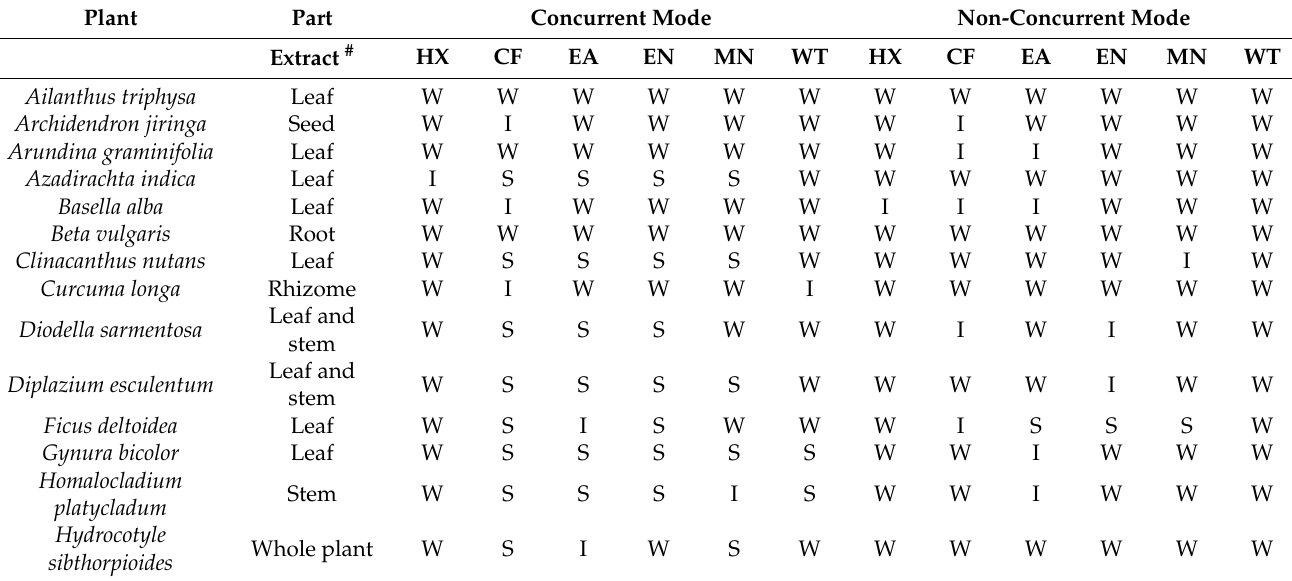
Table 2. Classification of cytopathic effect inhibitory activity of each medicinal plant extract for the concurrent and non-concurrent